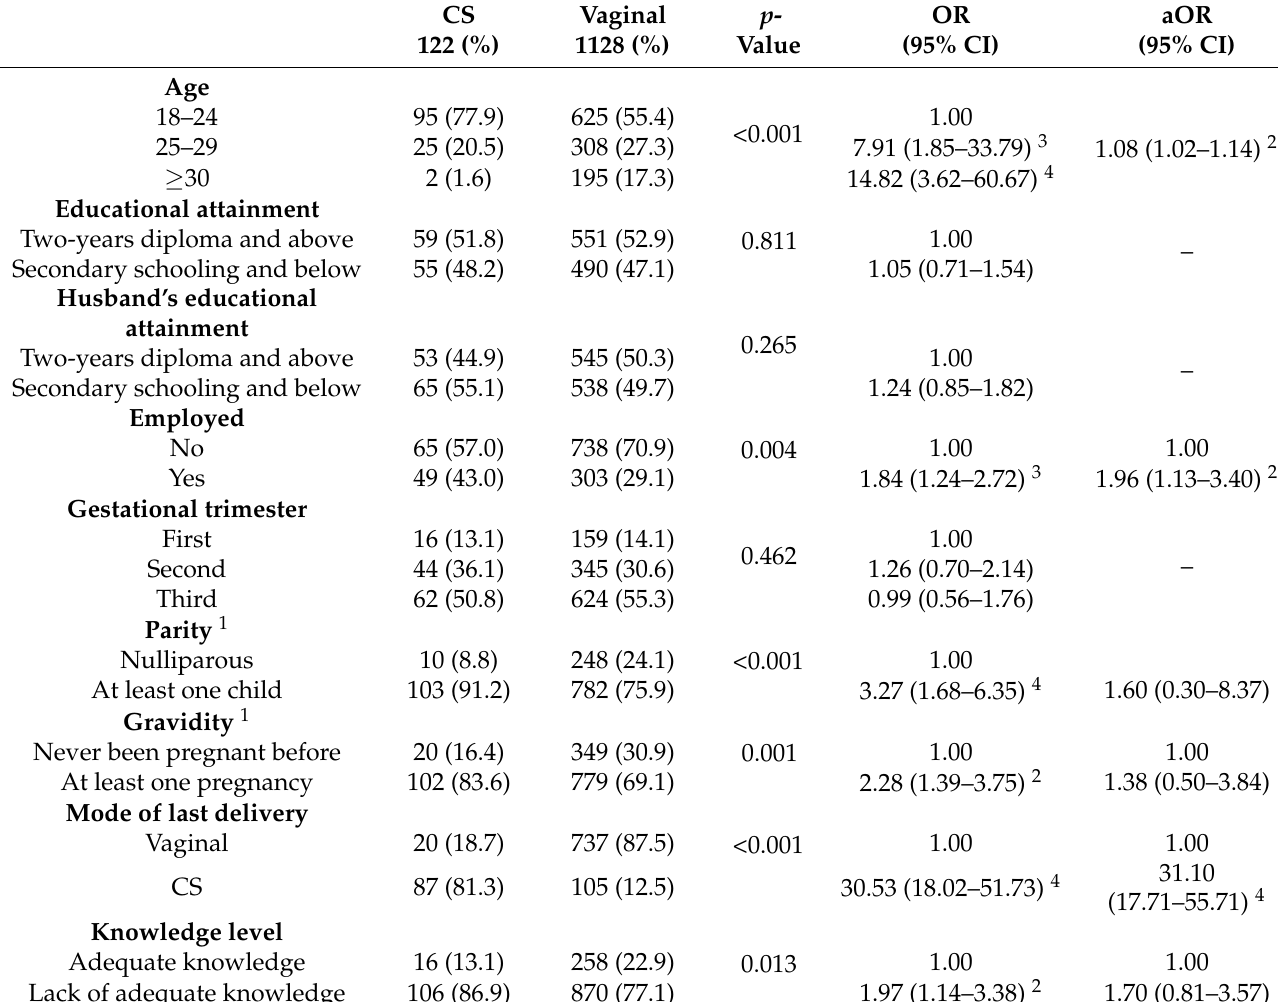
Table 4. Distribution of pregnant women according to preferred mode of delivery and factors associated with opting for CS